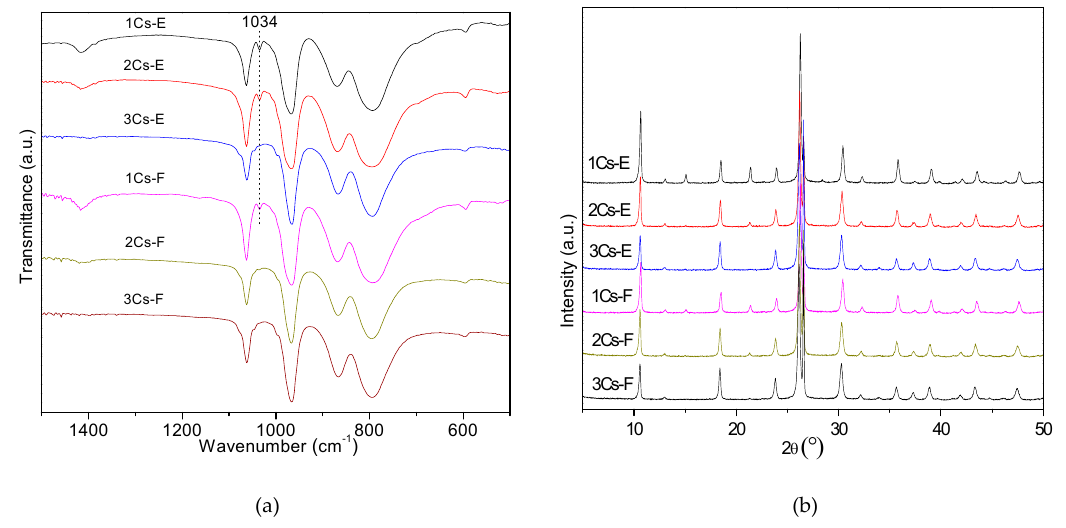
Figure 3. FT ‐ IR spectra ( a ); and XRD patterns ( b ) of the initial precipitates and the evaporation residues after calcination.